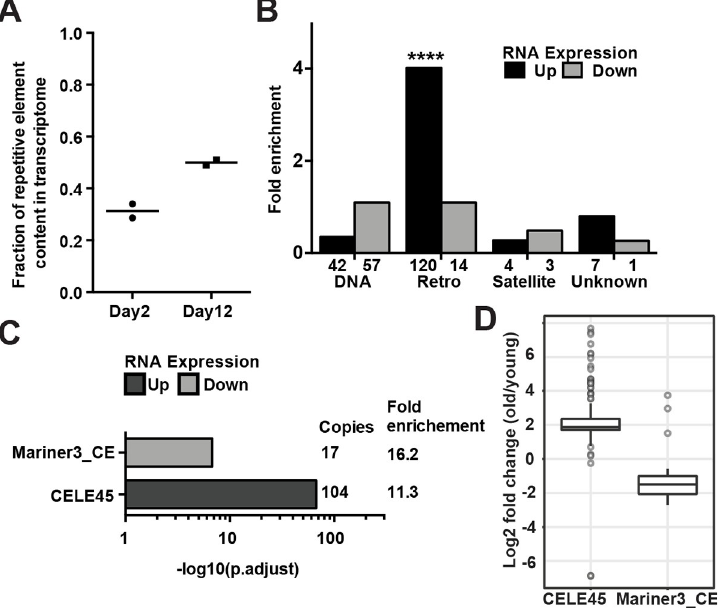
Fig 4. Overexpression of the putative SINE, CELE45, in aged somatic tissues. (A) The percentage of mapped RNA reads that originate from repetitive elements significantly increased during aging (two-tailed t-test, p -value = 0.023). Horizontal lines represent the mean of two biological replicates of ribo-depleted RNA-seq in young (day 2) and old (day 12) germline-less glp-1(e2141) worms. (B) Bar graphs showing the number of repetitive DNA elements in each group (DNA transposons, retrotransposons, satellite elements and unknown class) (x-axis) that showed significantly increased (Up) or decreased (Down) expression with age. Enrichment analysis revealed a significant over- representation of retrotransposon (adjusted p- value = 7.14 × 10 − 68 ) among the repeats with significantly elevated expression. (C) Significant enrichment of CELE45 (104 copies) and Mariner3_CE (17 copies) in differentially expressed repeats in aged somatic tissues. (D) The box and whisker plots show RNA fold changes (log 2 ) of all expressed copies of CELE45 (150 copies) and Mariner3_CE (40 copies) during aging.